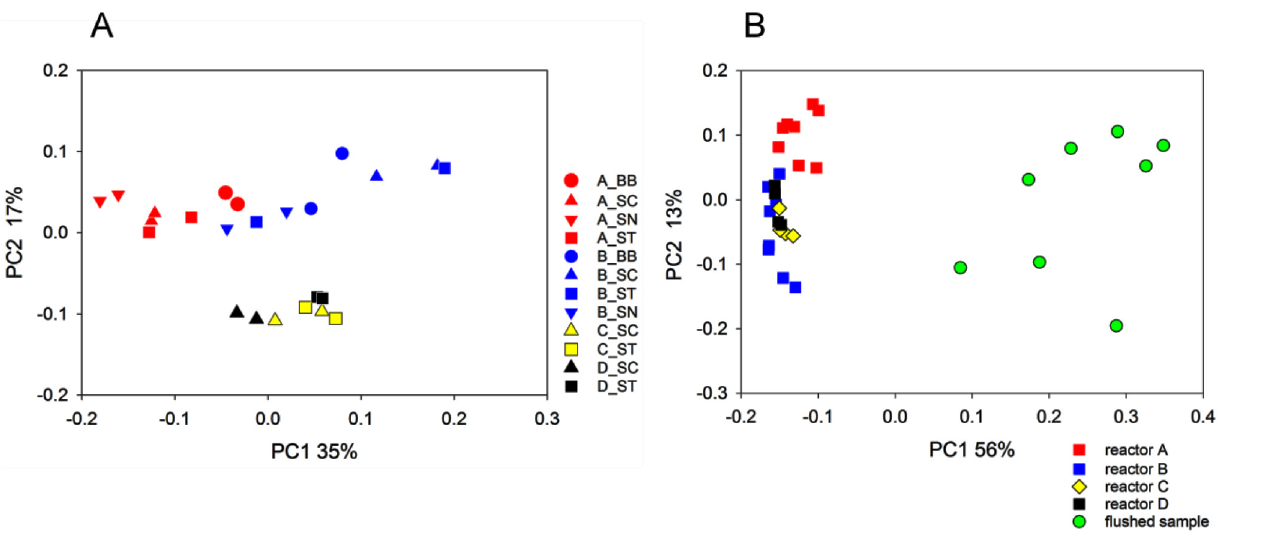
Fig 2. Principal Coordinate Analysis of reactor biofilms grown from flushed Golden State biofilms. A, 24 biofilm samples are represented according to biofilm recovery method (symbol) and reactor (color). The key indicates reactor_method, where circle = bead beating (BB), triangle up = scraping (SC), triangle down = sonication (SN), and square = stomaching (ST). B, PCoA illustrating distances between flushed (n = 8) and reactor biofilms. Distances between symbols are indicative of phylogenetic (Unifrac) distance. Percent variation explained by each axis is indicated.